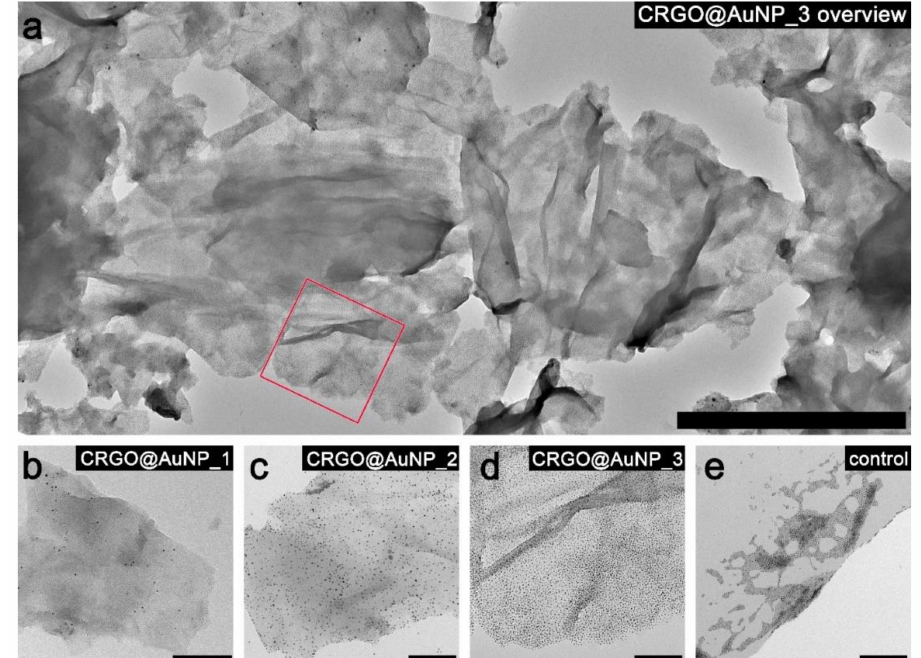
Figure 6. TEM micrographs of di ff erent graphene–spherical nanoparticles composites. ( a ) A zoom-o ff image of GNP-2 material showing several graphene sheets decorated with nanoparticles. ( b – d ) Zoom-in TEM images taken for GNP-1, GNP-2, and GNP-3 materials, respectively. Scale bar in image ( a ) represents 2 µ m and in images ( b – e ) 200 nm. The red square in image ( a ) corresponds to the area of the sample shown in panel ( d